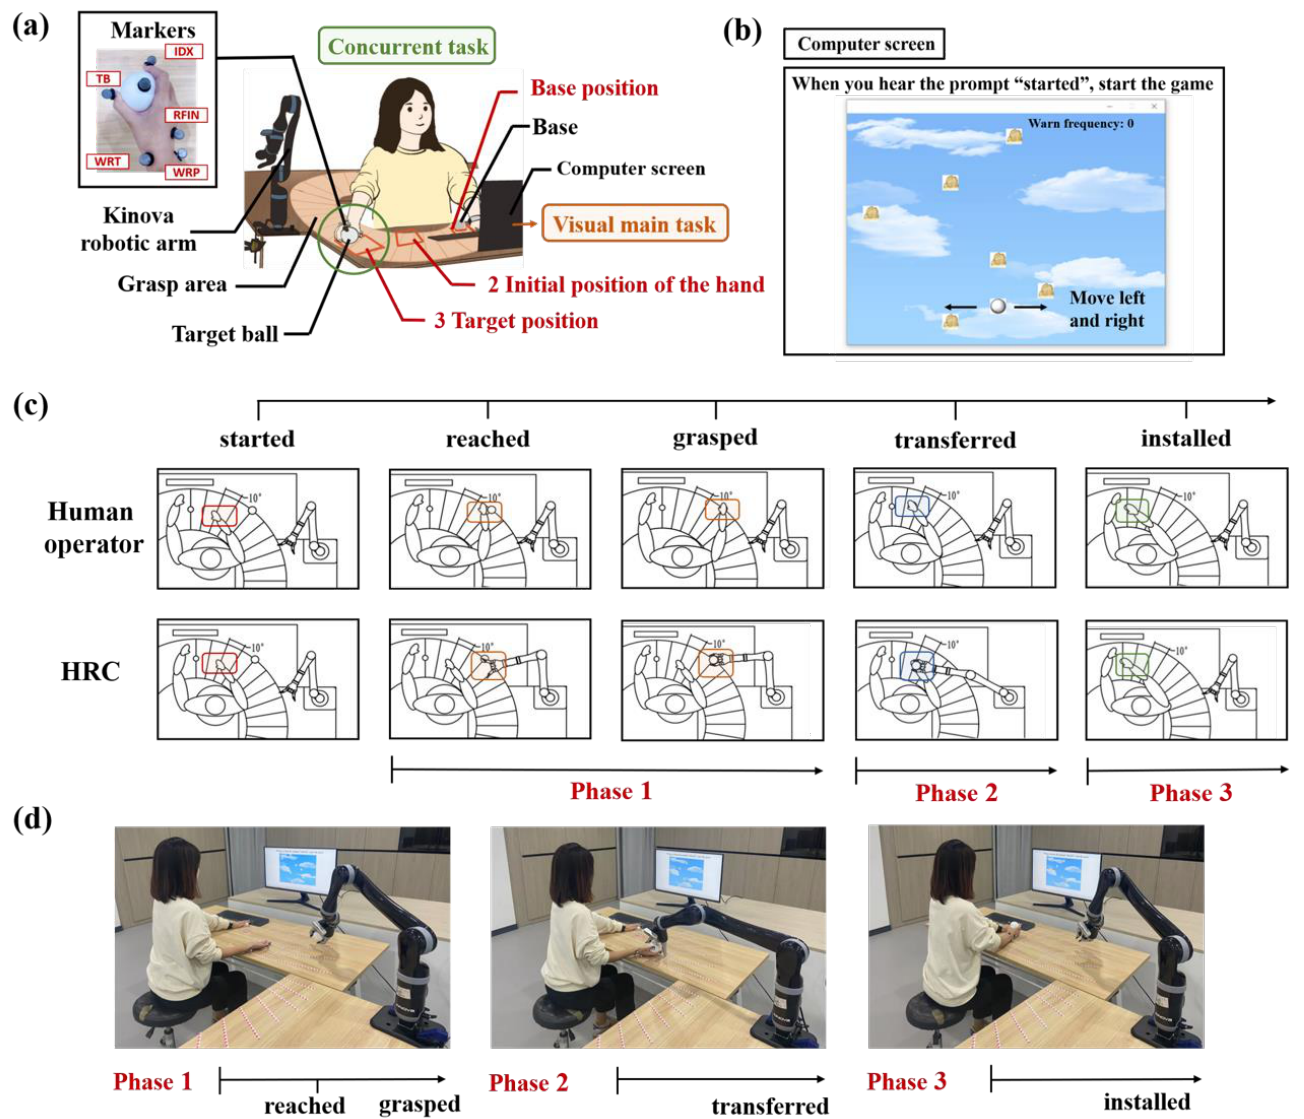
Figure 4. The experimental setup is shown in ( a ). The human operator accomplishes the grasping task concurrently while completing the visual main task on the computer screen. The visual main task for the ball collision game is shown in ( b ). An outline for every experimental session of the experiment is shown in ( c ). ( d ) Photographs of the experimental setup demonstrated the experimental process after incorporating the robotic arm assistance. The person permitted the use of this image.